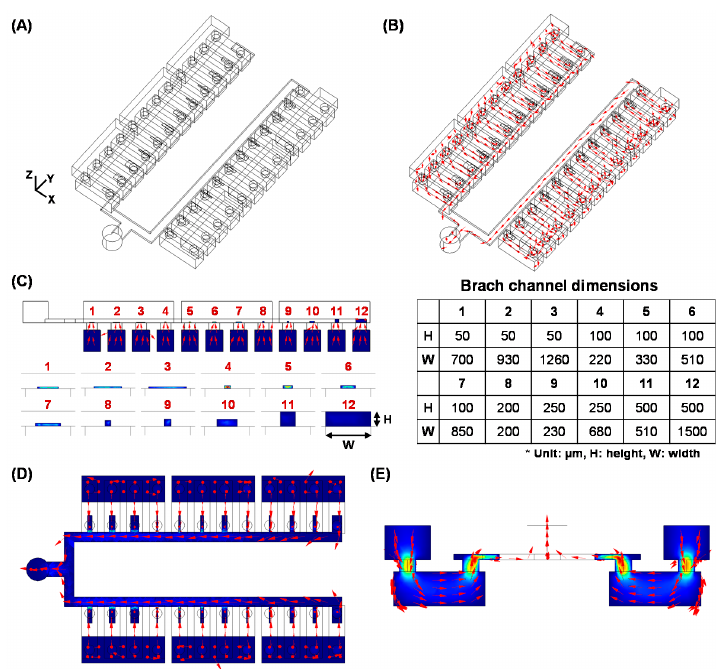
Figure 4. Numerical simulation results of the culture medium flow profiles during the replenishment process. ( A ) 3D illustration of the culture medium outflow channel connected to the axon compartments and the reservoirs as well as the culture medium exchange port. ( B ) Normalized culture medium flow streamline showing the flow direction from the reservoirs to the culture medium exchange port. ( C ) y - z cross-sectional view at the center of branch channel part of which enlarged views show the design used for matching the fluidic resistance at each axon compartments. Table illustrates the dimensions of each branch channel used. ( D ) x - y cross-sectional view at the culture medium outflow channel. ( E ) x - z cross-sectional view across the center of 12th branch channel part. Both (D) and (E) clearly show the culture medium flow profile collected at the medium exchange port through axon compartments and the culture medium outflow channel under a negative pressure applied condition. Neurons from E16 rats were added into the soma compartment and cultured up to 12 days in vitro and axons successfully differentiated from neuronal somata and passed through the microchannel arrays into the neighboring axon compartment (Figure 5A). The shallow height of the microchannels confined neuronal somata to the soma compartment and the ridge structure allowed somata to position close to microchannels, resulting in dense isolated axonal network formation at DIV 12 (Figure 5B,C).